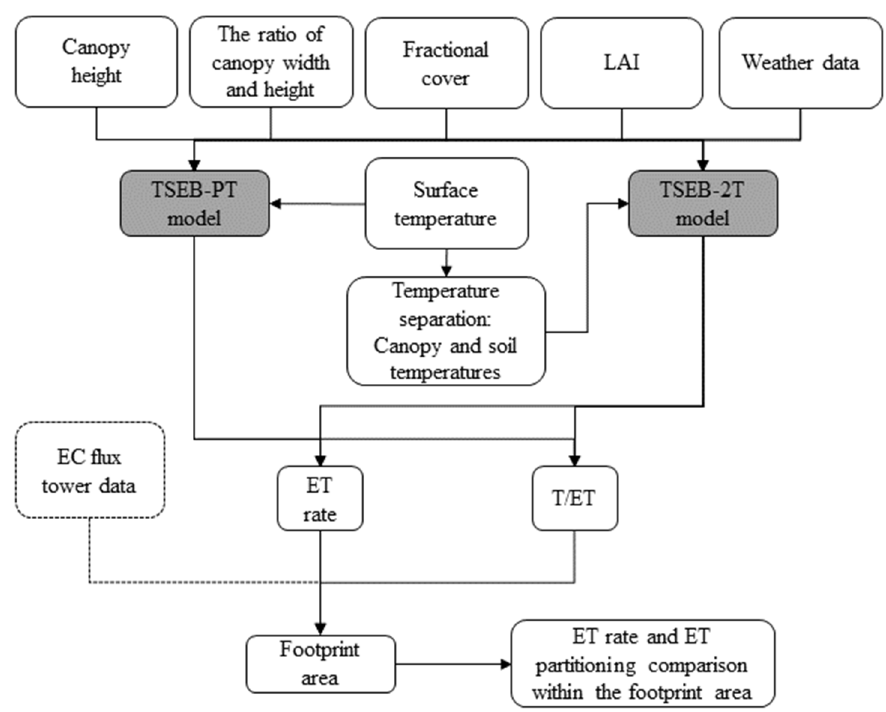
Figure 2. Flowchart showing the process of comparing ET rate and ET partitioning from TSEB models within the footprint area. The top 5 boxes, along with surface temperature in the second row, are the inputs for the TSEB models. The ET rate and T/ET were extracted within the corresponding footprint area and then compared with the EC flux tower monitored data.